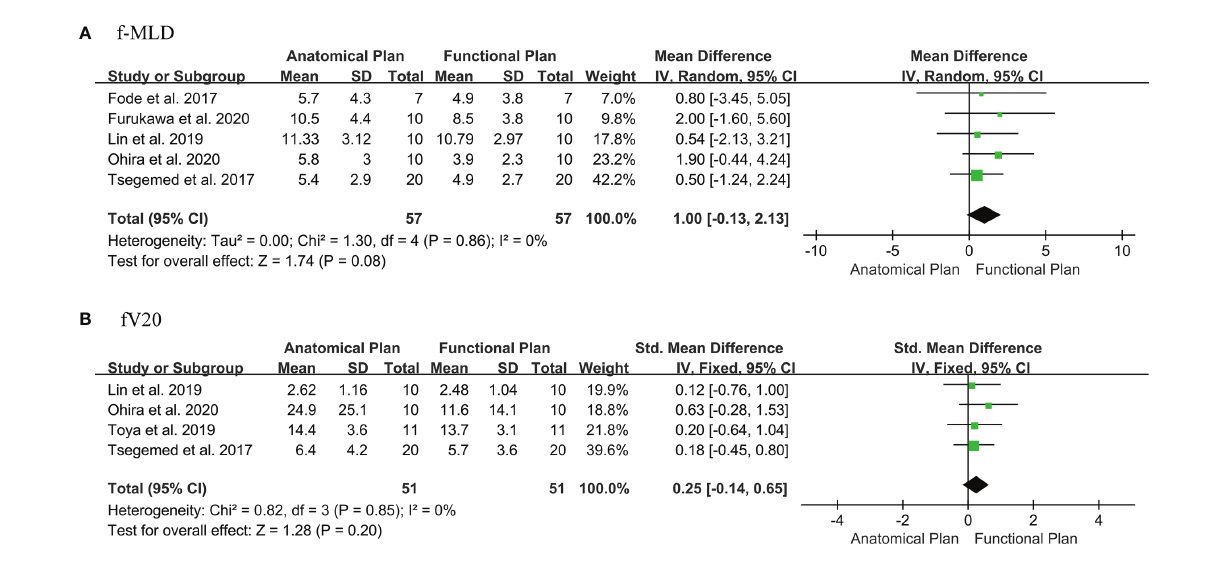
FIGURE 2 | Forest plot of the difference in dose-volume parameters of functional liver between the functional liver-sparing and conventional anatomical plans. (A) f-MLD (functional liver mean dose); (B) fV 20 (functional liver volume receiving ≥ 20